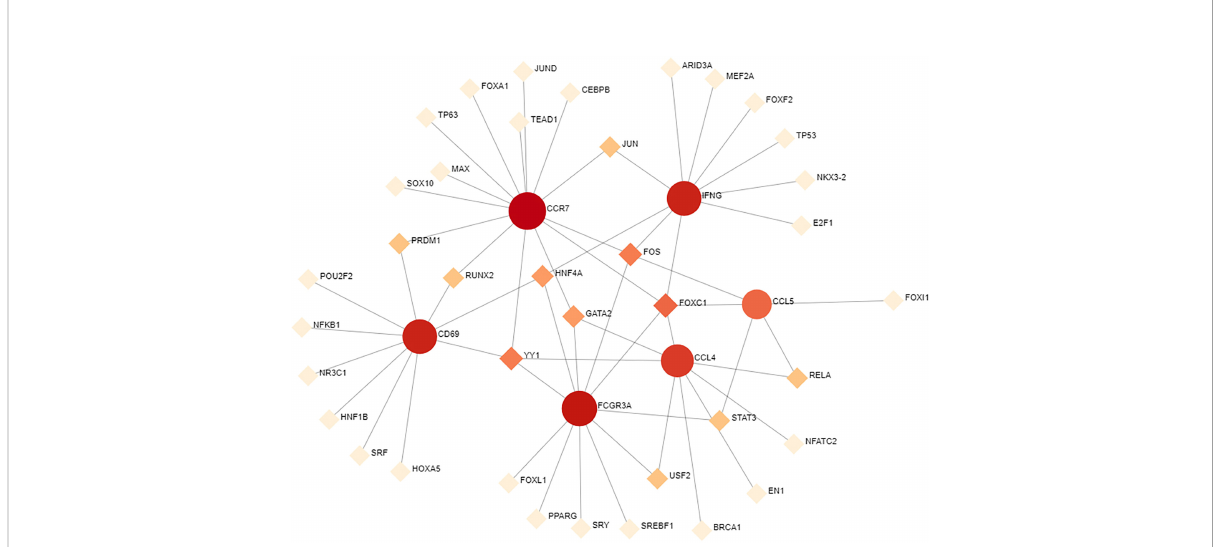
FIGURE 5 TF – gene interaction network analysis. Round dots indicate hub genes; square dots indicate TFs. Darker colors indicate association with a greater number of hub genes and a higher degree of association. TF, transcription